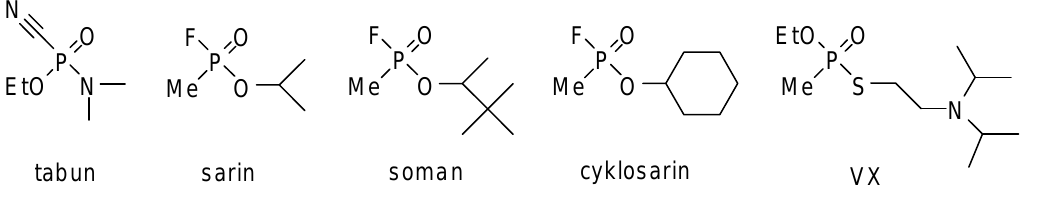
Figure 1. Organophosphorus inhibitors of acetylcholinesterase known as nerve agents.